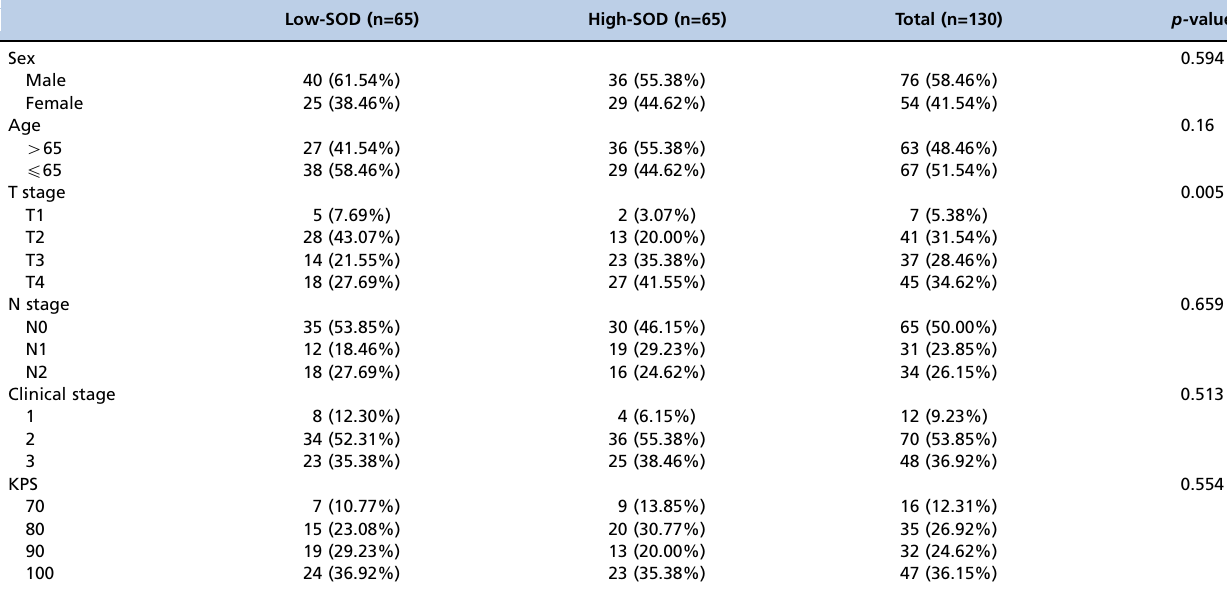
Figure 1 - Flowchart depicting participant selection for this Table 1 - Baseline patient characteristics.